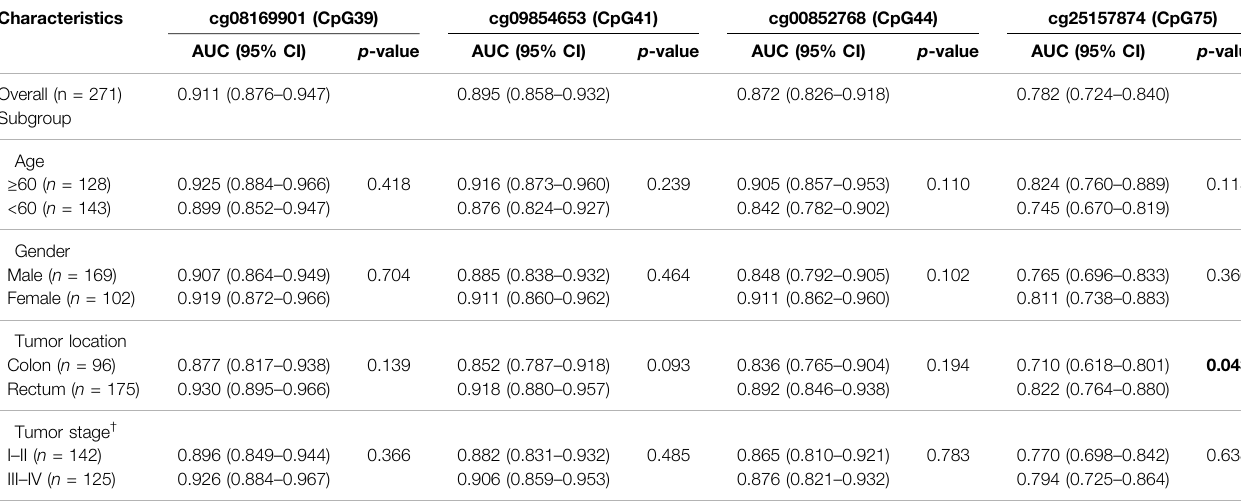
TABLE 2 | The AUC values of four CpG sites in the subgroup of different clinicopathological factors in the validation dataset.